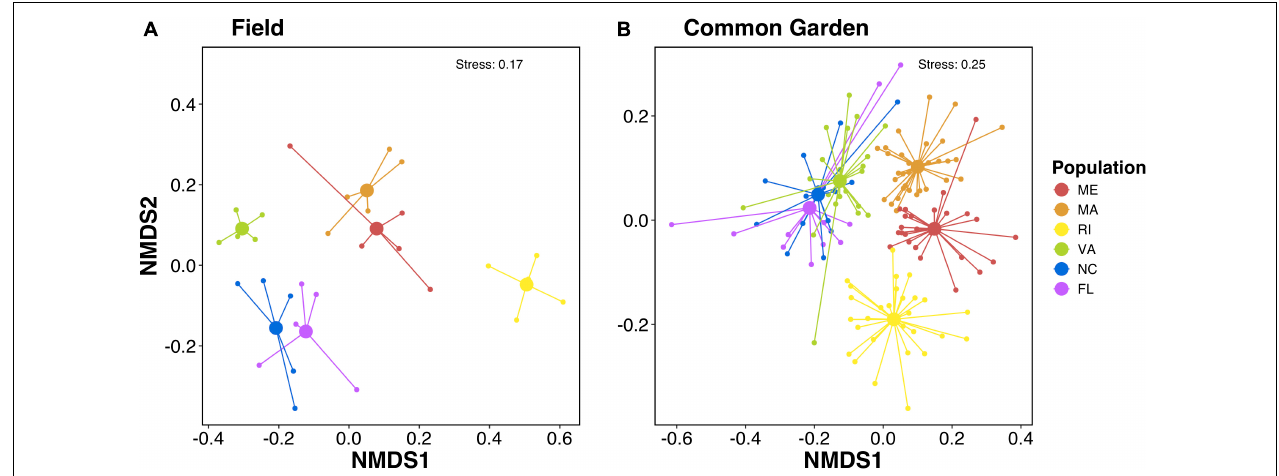
FIGURE 1 | Non-metric multidimensional scaling (NMDS) plots of sorensen-dice dissimilarities of microbial communities associated with the gills of (A) field and (B) common garden oysters. PERMANOVA results show significant effects of population on microbial community composition for both field ( p < 0.001) and common garden ( p < 0.002). Colors represent oyster